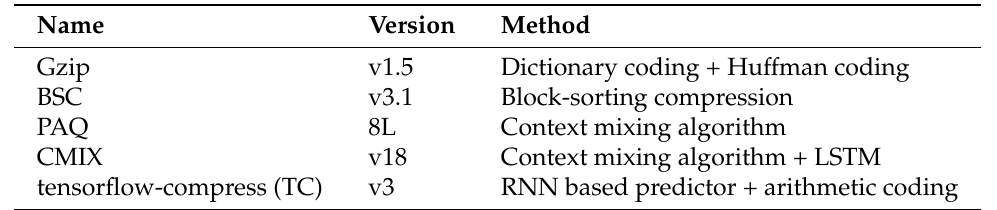
Table 3. Details of the compared